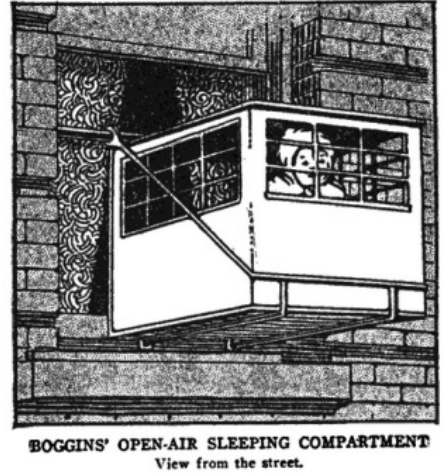
Figure 21. Open Air Window Crib (Fischer 1920, p. 6).